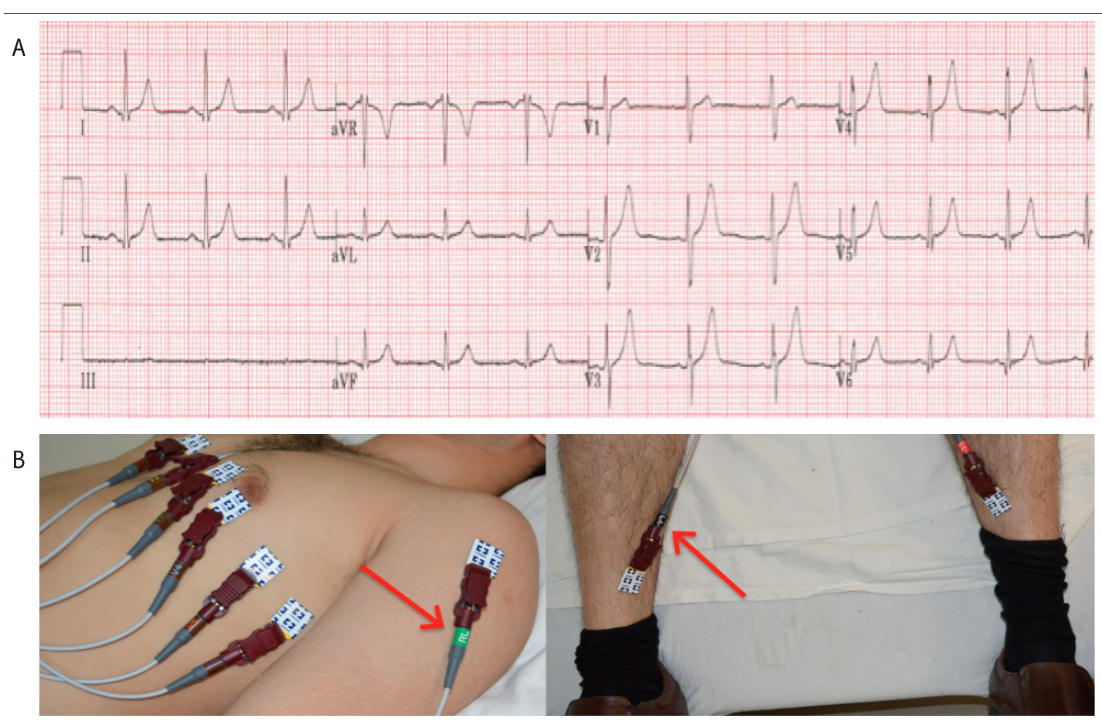
Figure 5. 12 lead ECG depicting left leg and right leg reversal. (A) ECG recording. (B) Arrows point to reversal of leads on left leg and right leg.